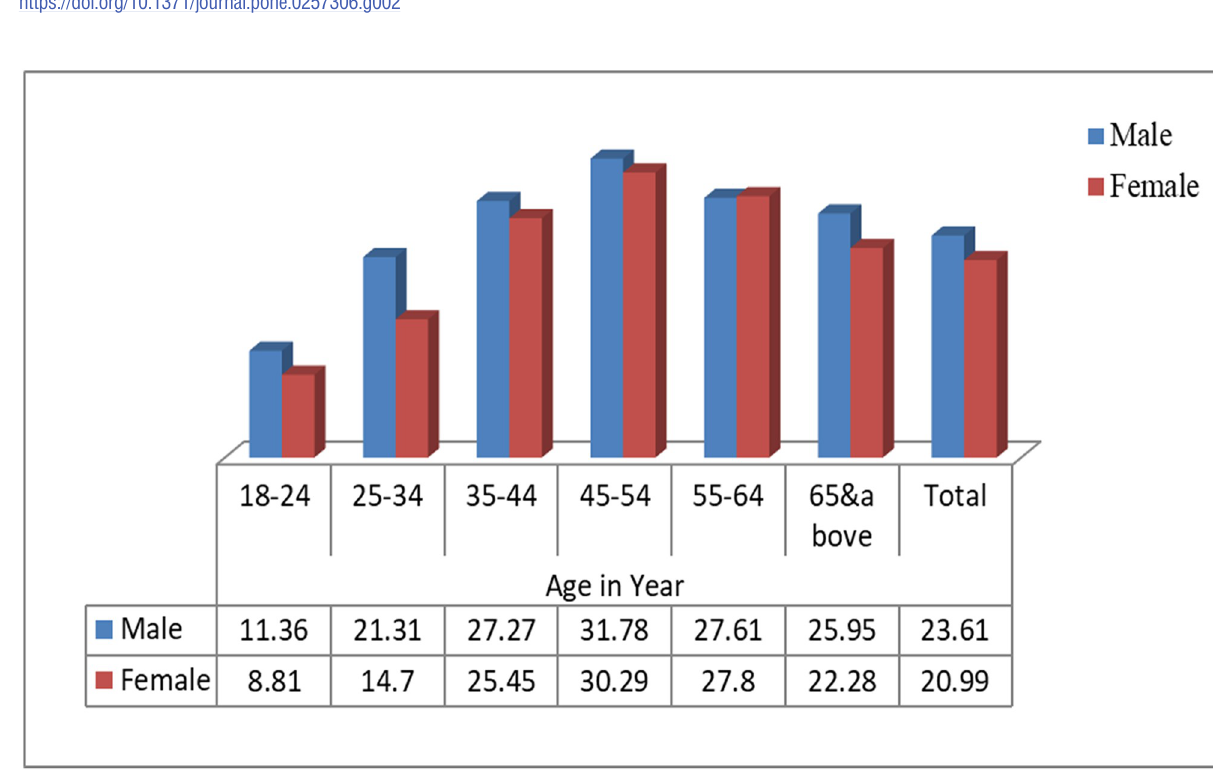
PLOS ONE | https://doi.org/10.1371/journal.pone.0257306 October 7, 2021 8 /